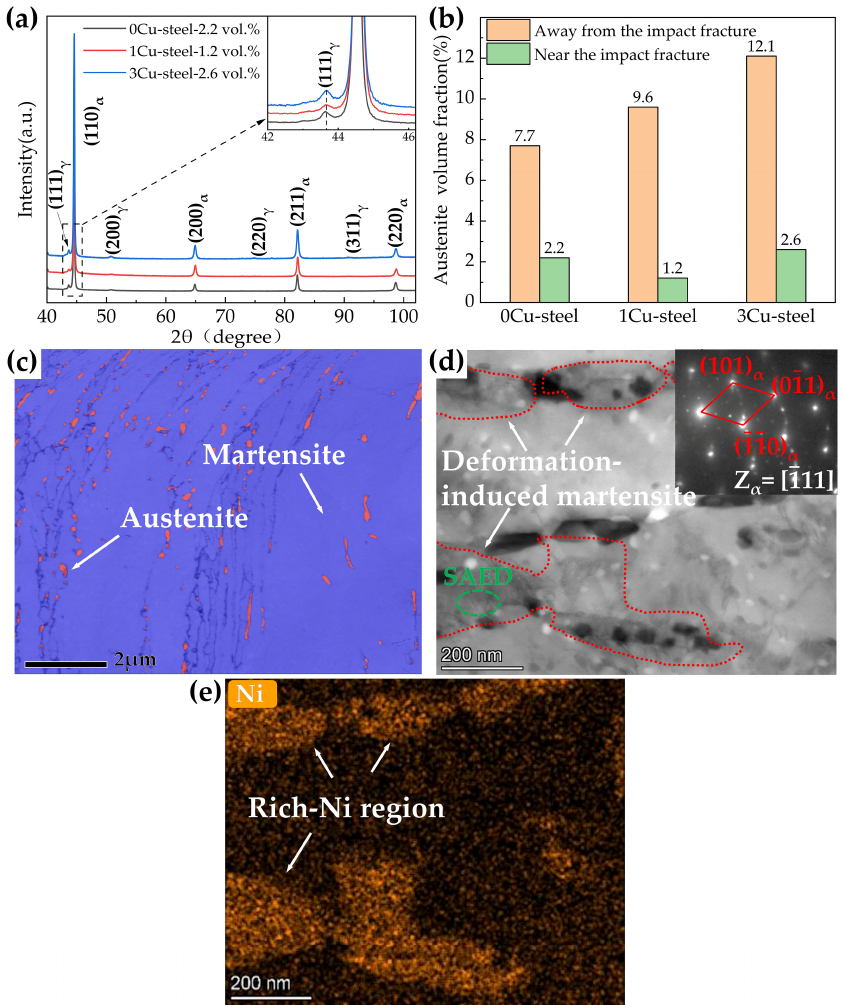
Figure 13. ( a ) XRD patterns of the three steels with different Cu content tempered at 600 °C near the impact fracture. ( b ) Volume fractions of reversed austenite near and away from the fracture. ( c ) The TKD band contrast (BC) and phase map of 3Cu ‐ steels tempered at 600 °C near the impact fracture. ( d ) Bright field TEM image and the corresponding electron ‐ diffraction analysis from the selected area of 3Cu ‐ steels tempered at 600 °C. ( e ) EDS mapping of Ni for 3Cu ‐ steels tempered at 600 °C.